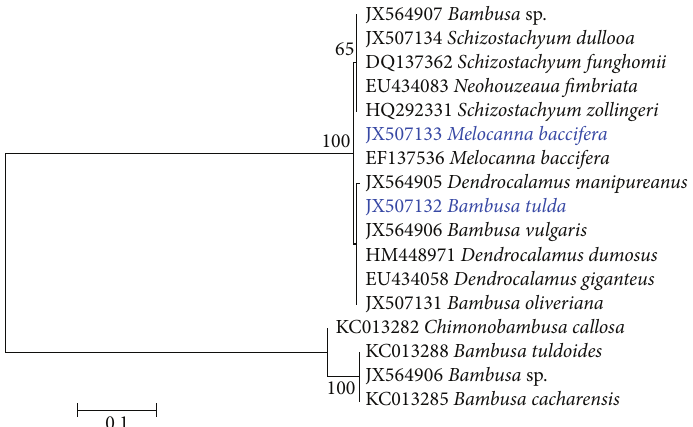
Figure 1: Molecular phylogenetic analysis by maximum likelihood method based on the T93 substitution model [9]. AIC is 1551.28, BIC is 1763.70, the highest log likelihood is − 741.59, and bootstrap values ≥ 50% from 1000 iterations are shown. The taxa we developed in vitro plantlets regeneration based on nodal explants are highlighted in blue.